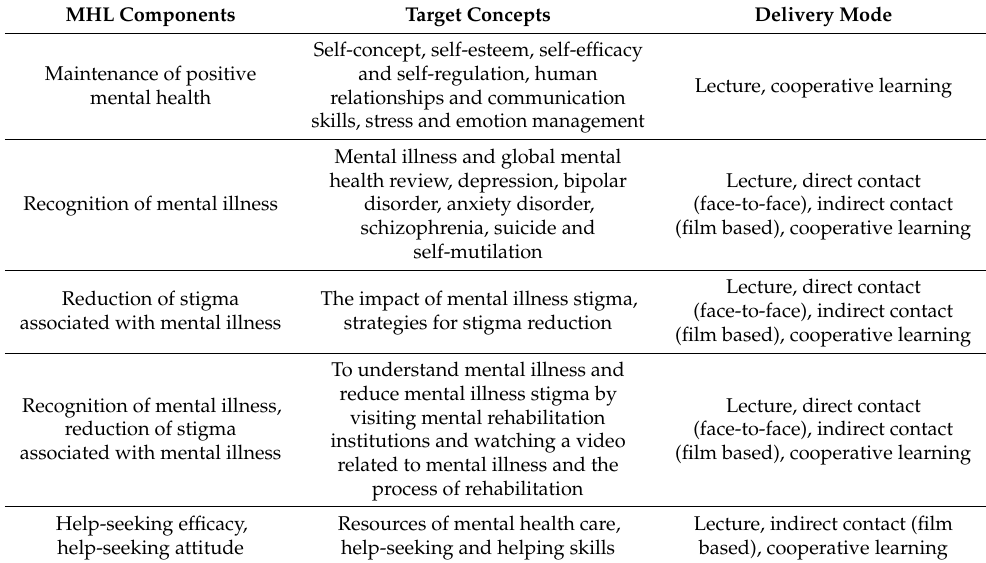
Table 1. MHL curriculum components, target concepts and delivery